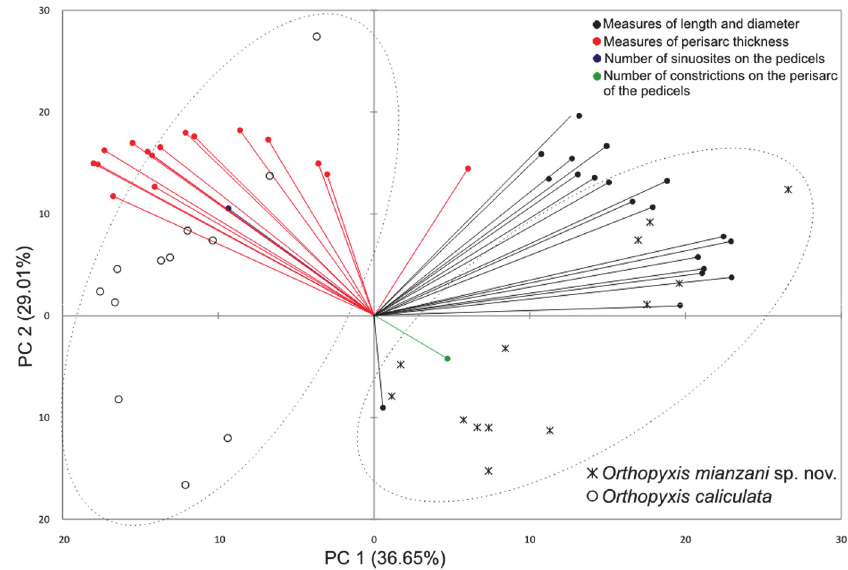
Fig 7. Correlation biplot of the first and second principal components of the PCA based on morphometric variables of Orthopyxis caliculata and Orthopyxis mianzani sp. nov. from the southwestern Atlantic. The percentage of variation explained by each principal component is shown in